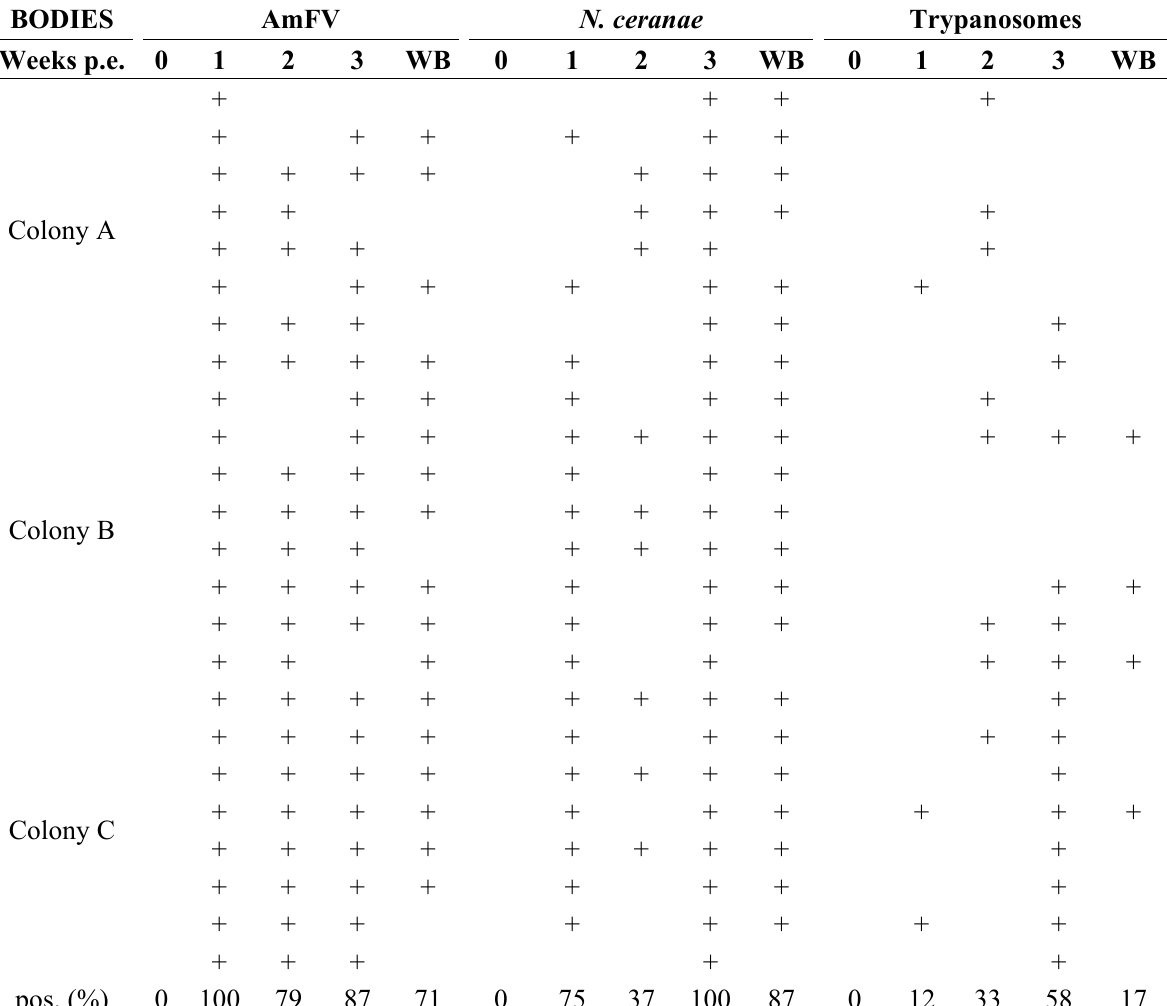
Table 2. Detection of Apis mellifera Filamentous virus (AmFV), Nosema ceranae and C. mellificae/L. passim in bodies (after gut removal) from individual bees at 0, 1, 2 or 3 weeks after emergence (weeks p.e.) and in winter bees (WB) ( n = 24 workers from 3 colonies). +: Percentage of PCR positive